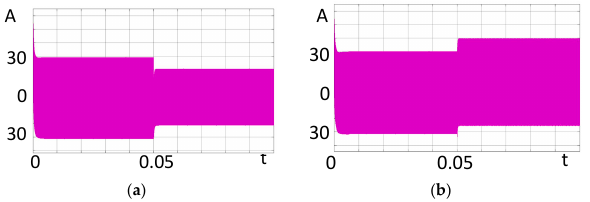
Figure 8. Inductance current waveform of ( a ) Optimal control mode; ( b ) Traditional control mode.